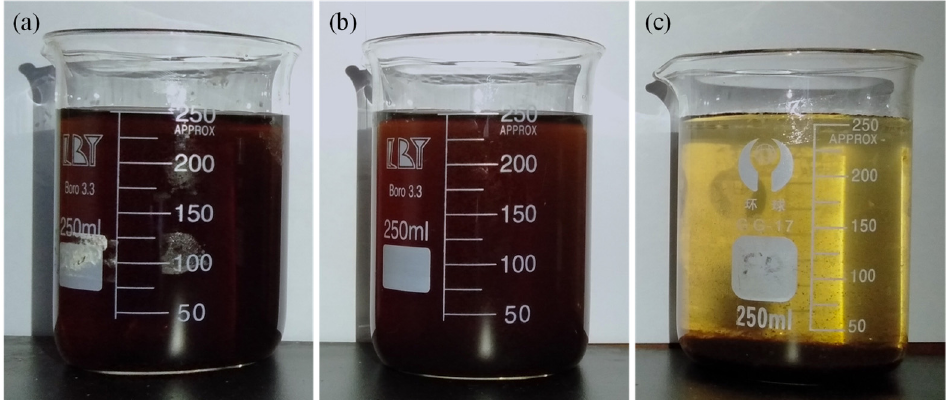
Figure 5. Optical images of HA solutions prepared after 24 h natural sedimentation with Ca 2+ concentration of ( a ) 0 mM, ( b ) 1.5 mM, and ( c ) 5.0 mM (HA concentration = 100 mg/L).